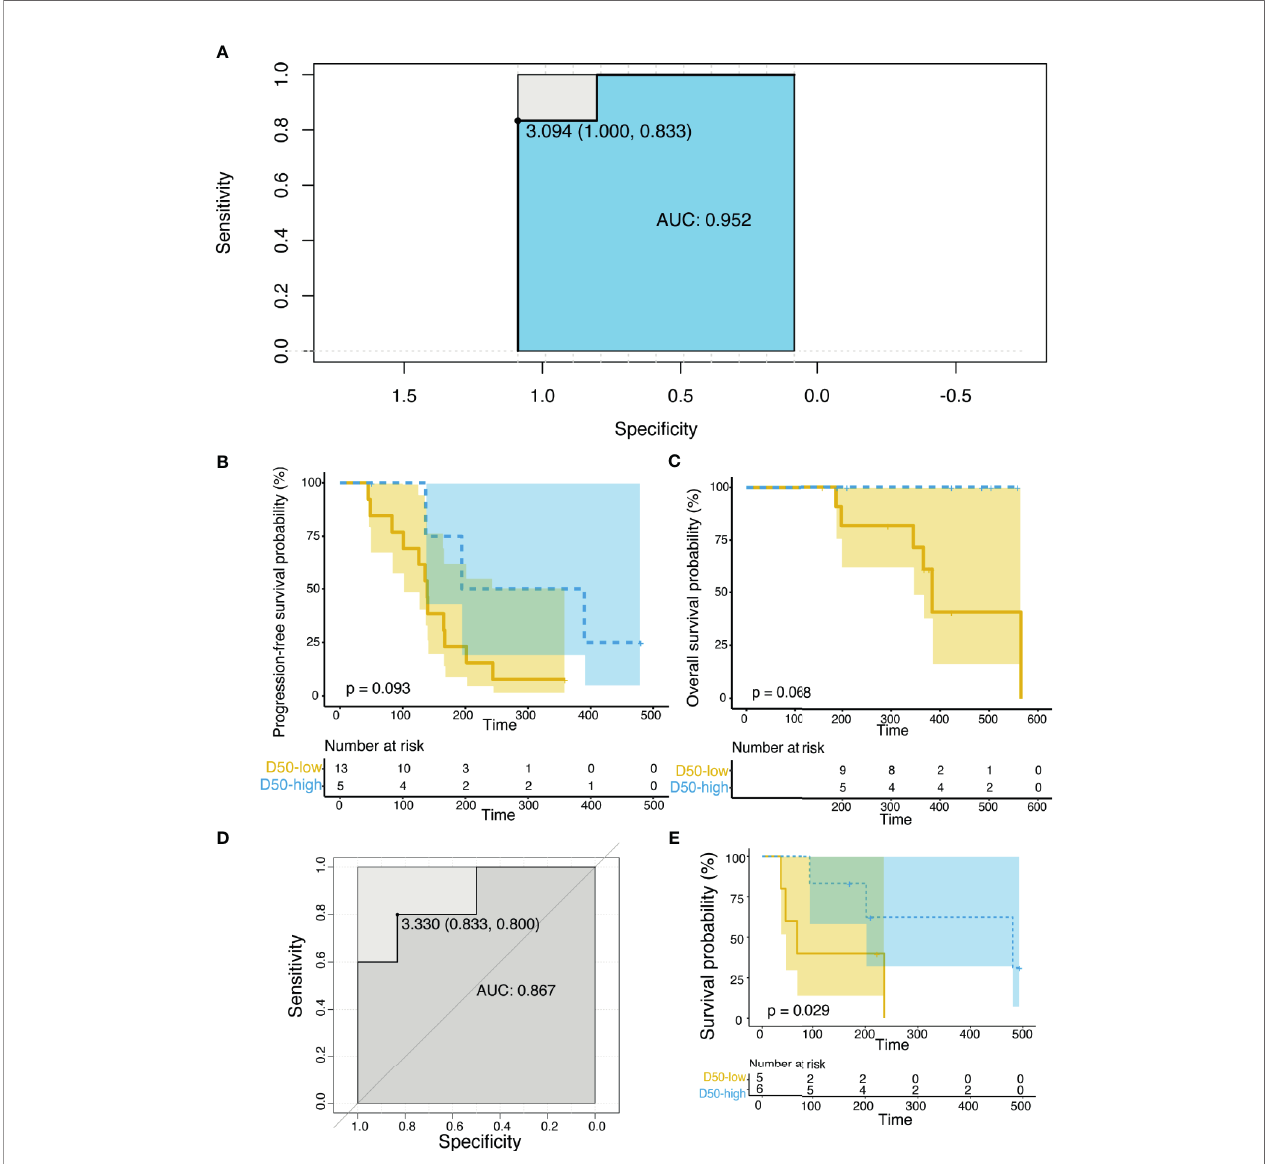
FIGURE 3 | Correlations between D50 index and progression-free survival rate in the discovery and validation cohorts. (A) ROC curve for the correlation of D50 index with response in the discovery cohort. AUC is 0.952. Cut-off of ≥ 3.09 D50 index is designated by triangle. (B) Correlations between D50 index and progression-free survival rate at post-treatment samples in the discovery cohort. (C) Correlations between D50 index and overall survival rate at post-treatment samples in the discovery cohort. (D) ROC curve for the correlation of D50 index with response in the validation cohort. (E) Correlations between D50 index and progression-free survival rate at post-treatment samples in the validation cohort. The survival curves were constructed using the Kaplan-Meier method and compared between groups classi fi ed by the D50 index in (B , D) . Signi fi cance was analyzed by log-rank